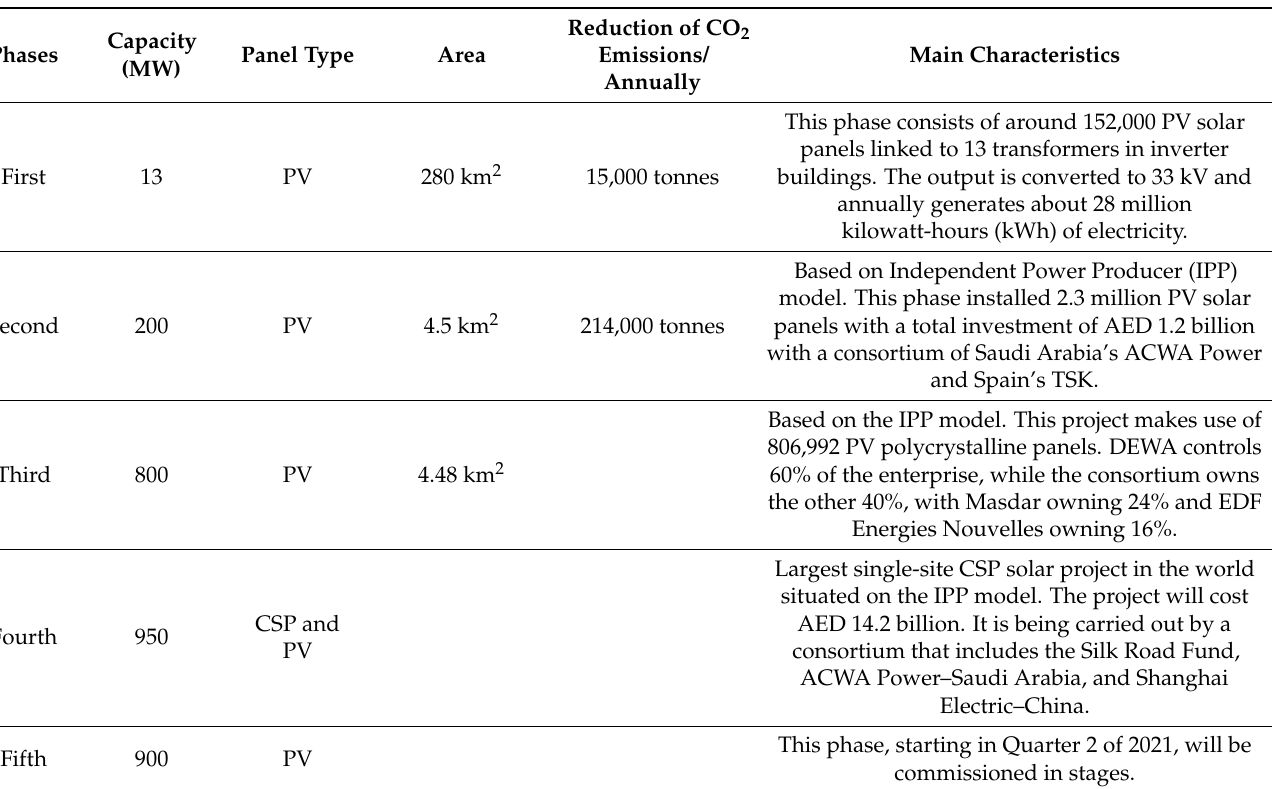
Figure 17. Solar projects in the Sheikh Mohammed bin Rashid Al Maktoum Solar Park, Noor 1 Photovoltaic Solar Power Project, Um Al-Zomul off-grid power project, and Shams 1 [92]. Table 3. List of the five phases of the Sheikh Mohammed bin Rashid Al Maktoum solar project with main